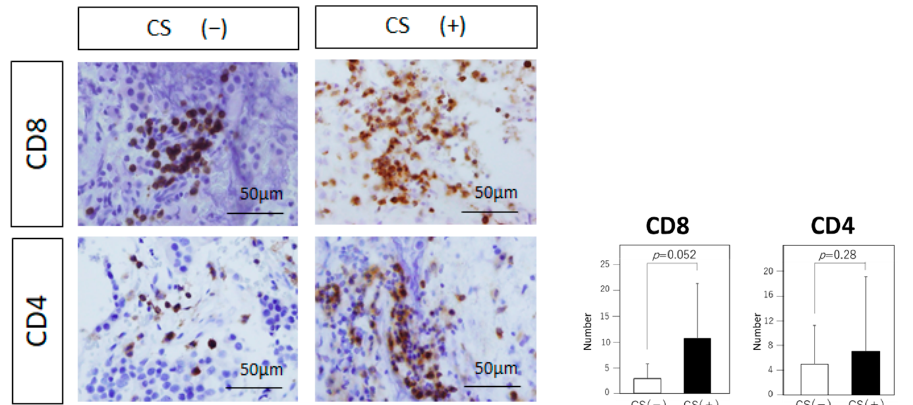
Figure 3. Analysis of tumor-infiltrating lymphocytes. Immunohistochemical analysis of CD8 and CD4 (Original magnification, ×20). Typical examples of each staining are shown in both groups. Statistical analysis of each staining is shown. The number of CD8 (+) lymphocytes tends to be higher in the CS (+) group than in the CS ( − ) group, but the difference is not statistically significant ( p = 0.052). The number of CD4 (+) lymphocytes shows no significant difference between the two groups ( p = 0.28). Data represent the mean ± standard error of mean (CD4 and CD8, student’s t -test).